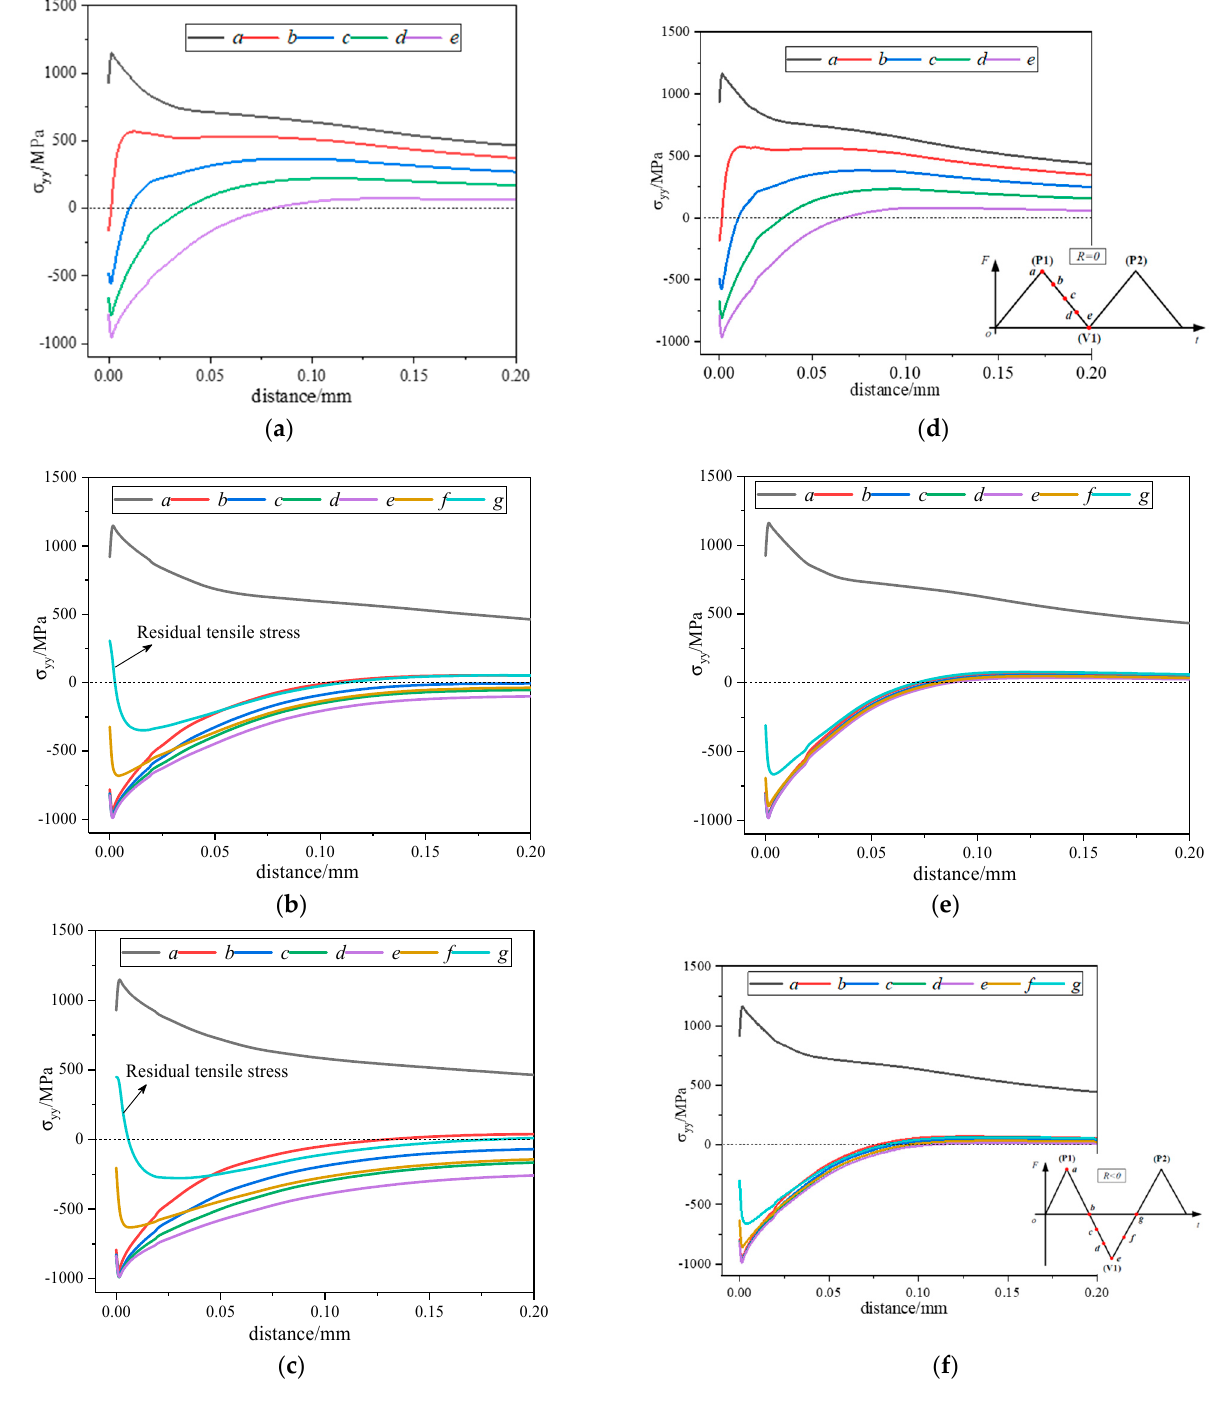
Figure 12. Normal stress distribution of: ( a ) K3-N, R = 0; ( b ) K3-N, R = − 1; ( c ) K3-N, R = − 2; ( d ) K1-S, R = 0; ( e ) K1-S, R = − 1; ( f ) K1-S, R = − 2.